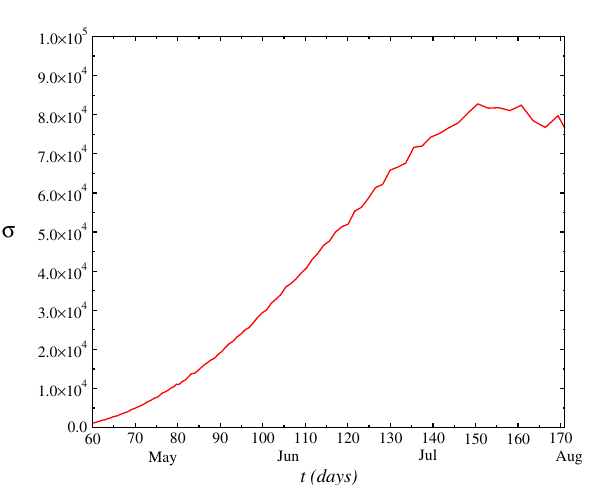
1 and β 2.0 10 6 . = = ×